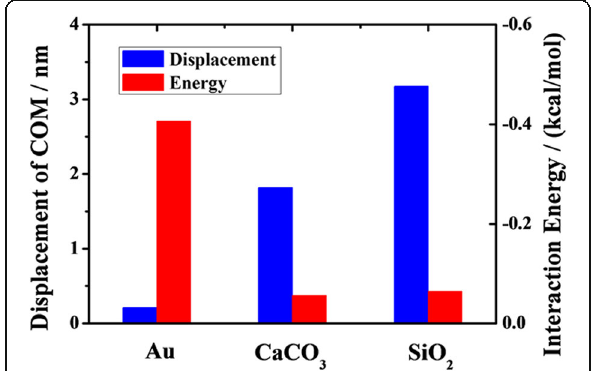
Fig. 10 The COM displacements of oil at 2 ns and average interaction energies between oil and substrates of different